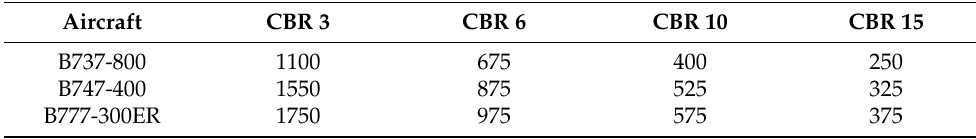
Table 3. Flexible pavement sub-base thickness (mm).